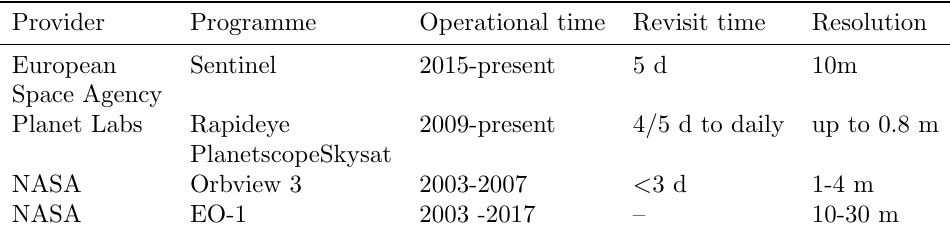
Table 2: Overview of other Earth observation satellites, their revisit time and spatial